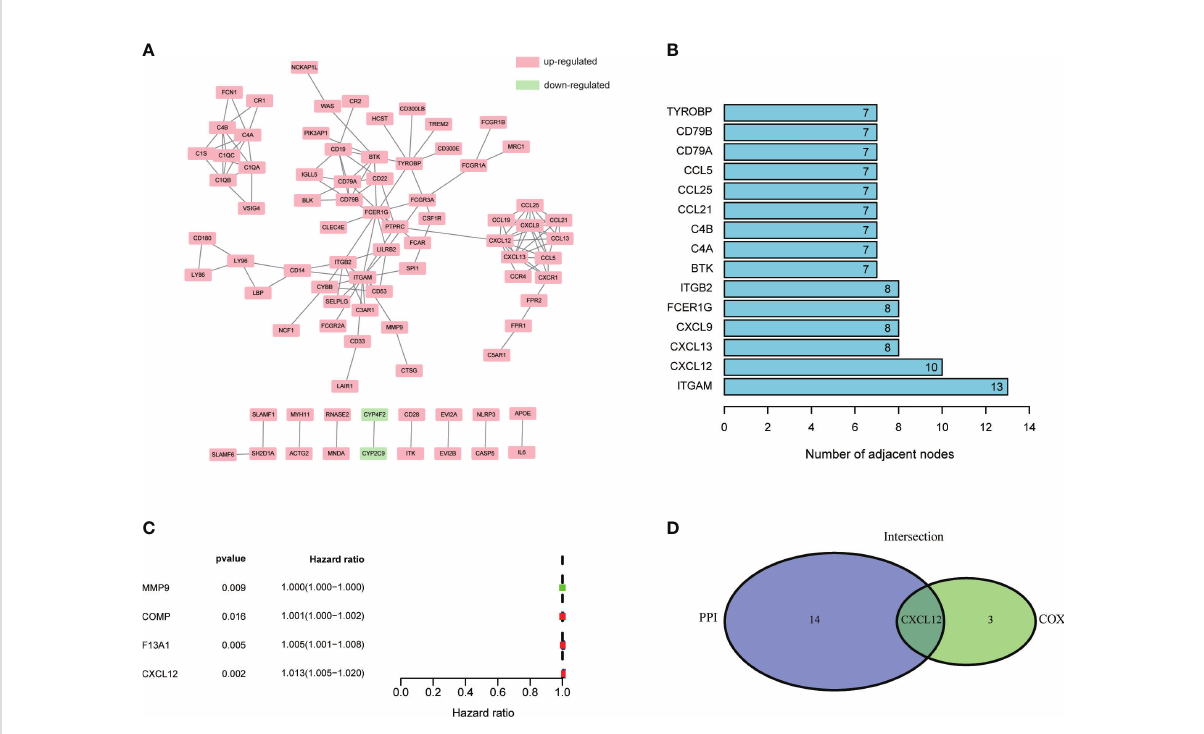
FIGURE 4 PPI network and univariable COX regression analysis of 284 DEGs. (A) PPI network was constructed by STRING database and Cytoscape software; interaction con fi dence value >0.95; (B) The top 10 genes which shared the leading nodes in PPI network; (C) Univariable COX regression analysis of 284 DEGs; p<0.05 was considered to be statistically signi fi cant; (D) Intersection analysis of DEGs which shared the leading nodes in PPI network and were closely related with BLCA patients ’ survival. p<0.05 was considered to be statistically signi fi